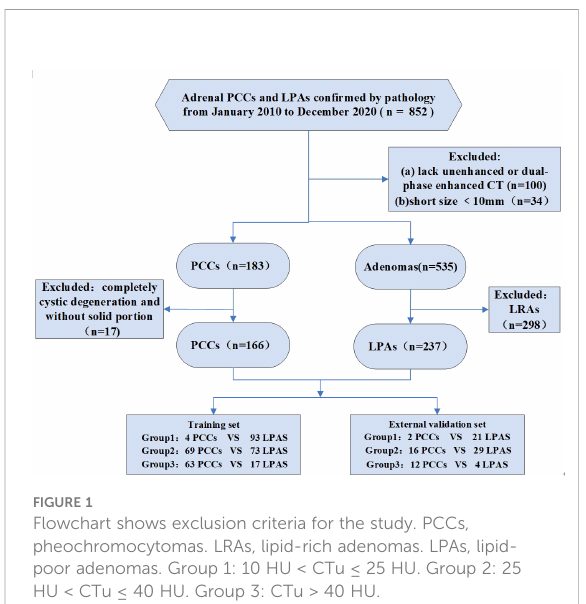
FIGURE 1 Flowchart shows exclusion criteria for the study. PCCs, pheochromocytomas. LRAs, lipid-rich adenomas. LPAs, lipid- poor adenomas. Group 1: 10 HU < CTu ≤ 25 HU. Group 2: 25 HU < CTu ≤ 40 HU. Group 3: CTu > 40